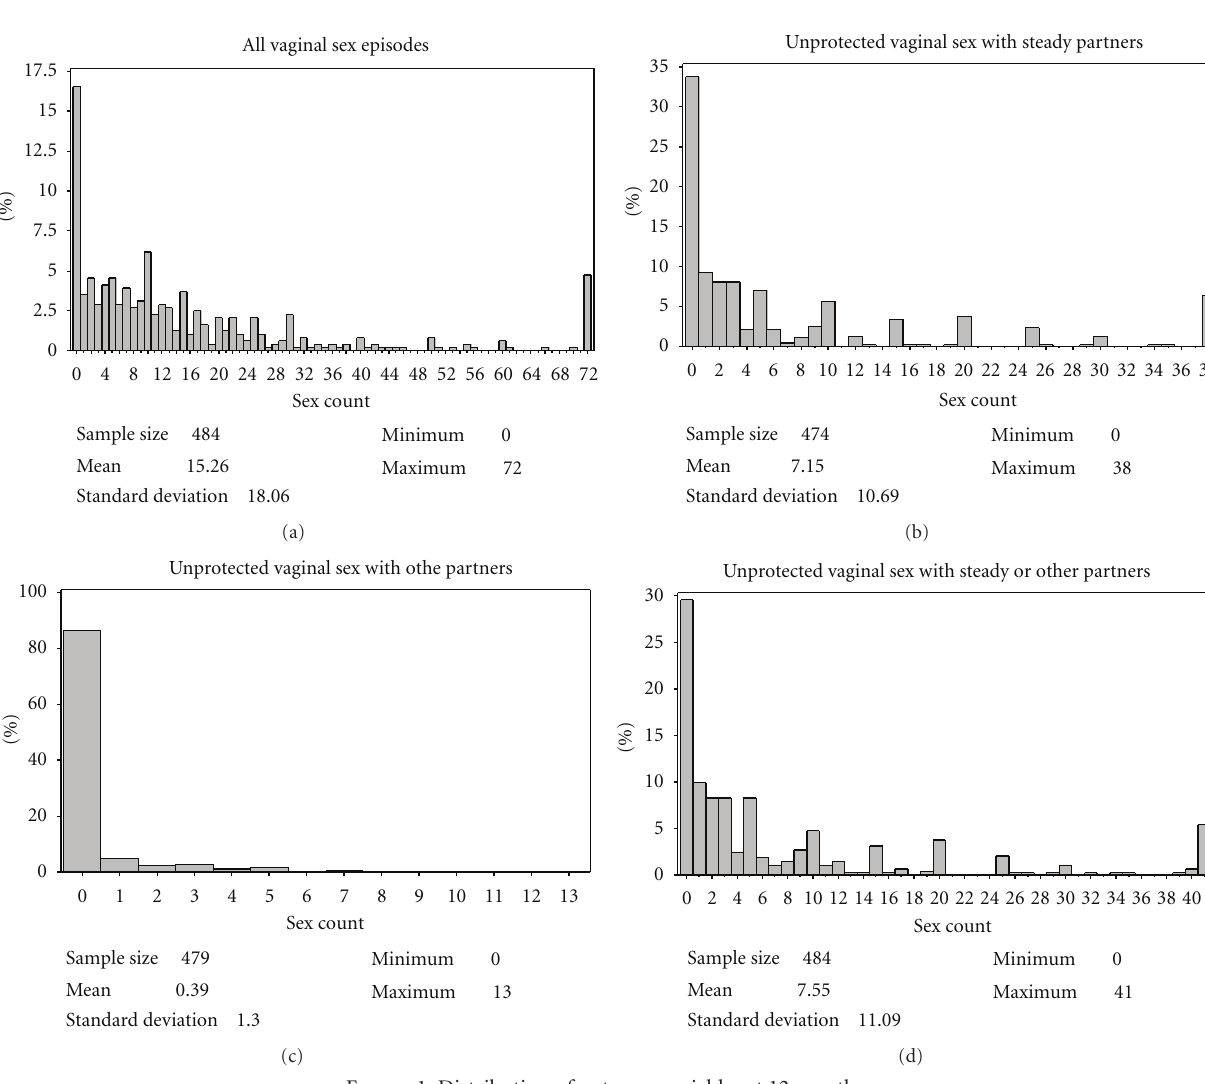
Figure 1: Distribution of outcome variables at 12